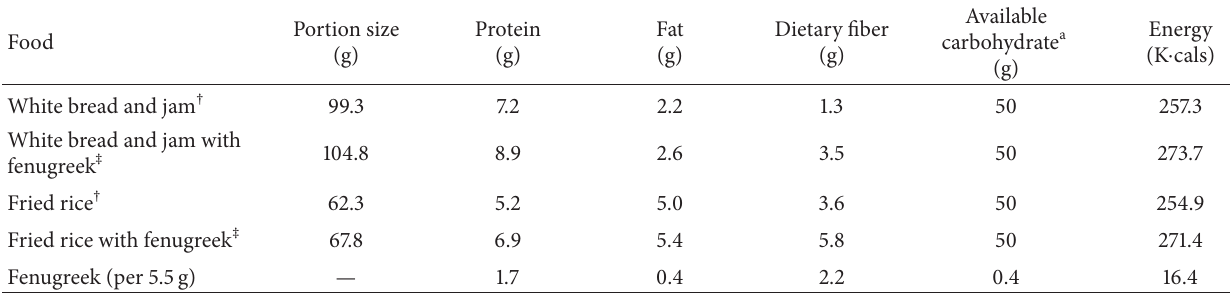
Table 1: Composition of control and test